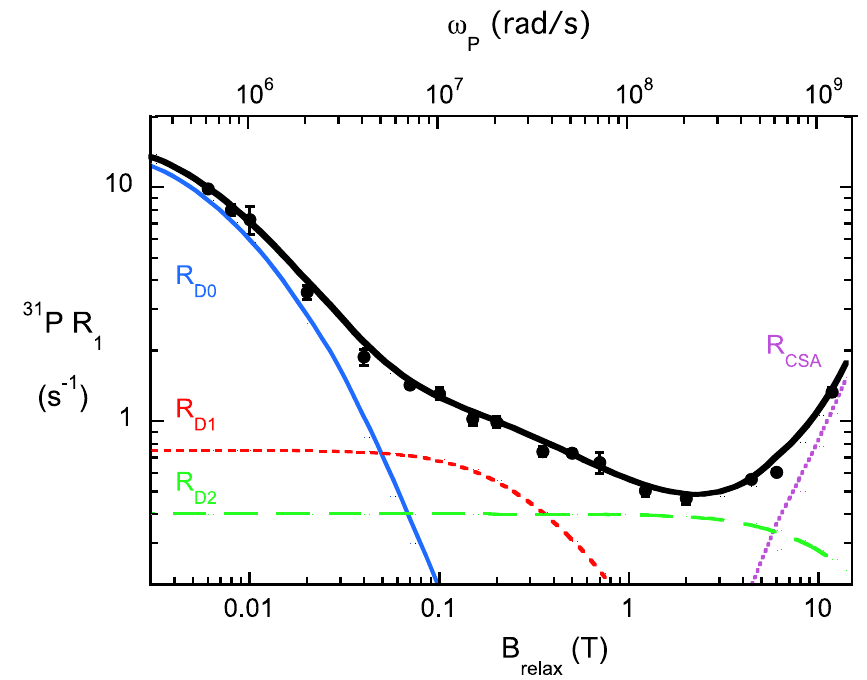
Figure 3. Dependence of R 1 for the POPC 31 P resonance in SUVs mixed 1:1 with d 3 -DOPMe with relaxation magnetic field, B relax . The deconvolution of the data into three dipolar NMRDs and a single high-field NMRD due to the 31 P chemical shift anisotropy is shown. The Larmor angular frequency, ω P , corresponding to γ P B relax , is shown on the top x-axis. Reprinted with permission from Roberts et al. (2021) J. Phys. Chem. B, 125, 8827–2238, Copyright 2021, American Chemical Society.